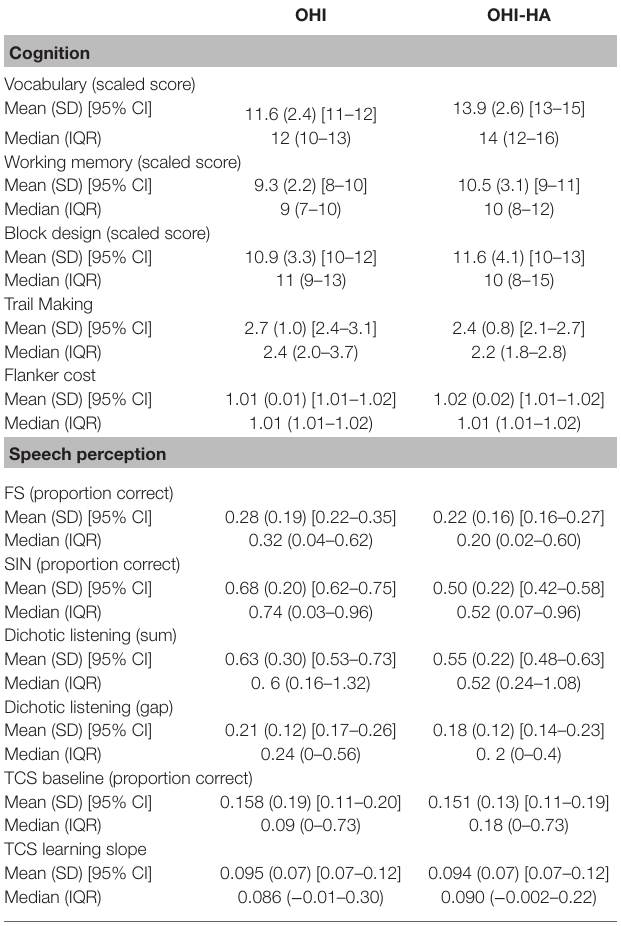
TABLE 3 | Correlations between speech perception, cognition, and learning among all